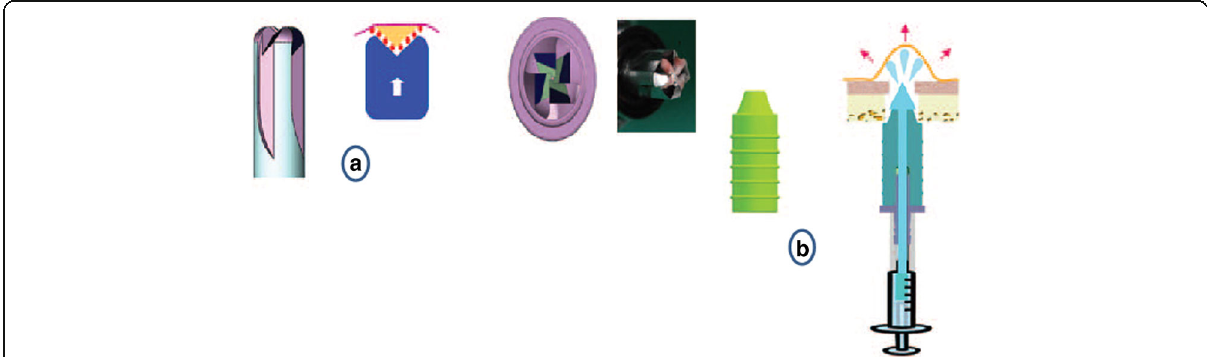
Fig. 5 a The CAS drill has four blades and an inverse conical shape. b The hydraulic